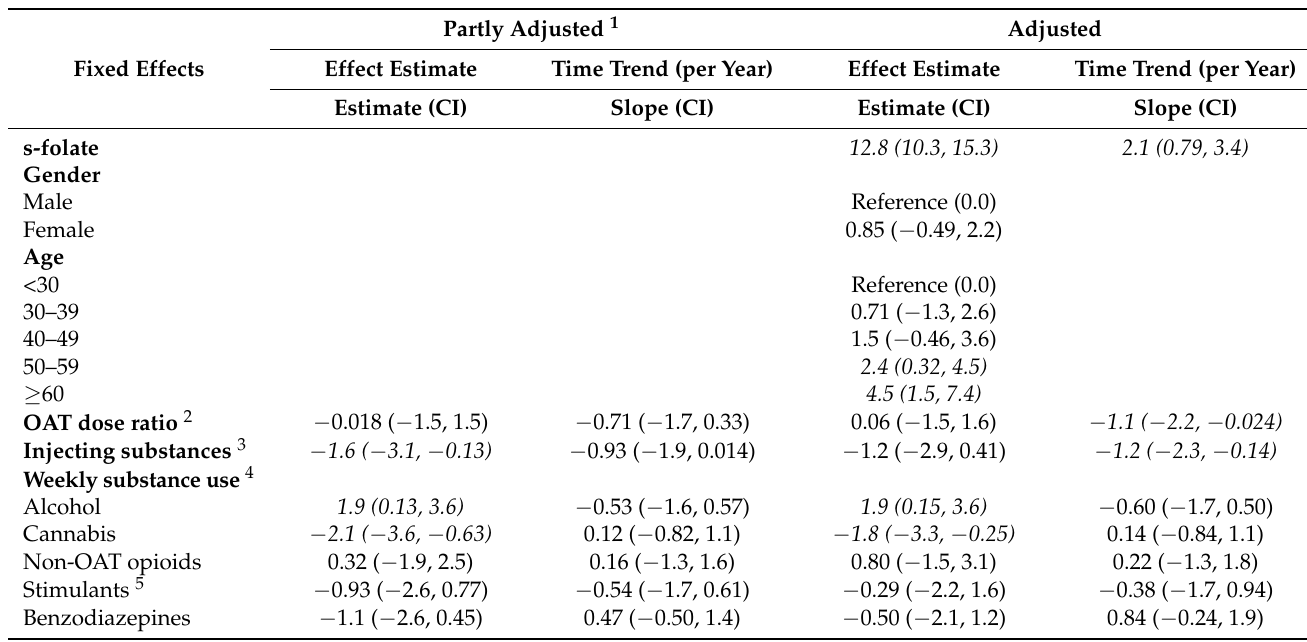
Table 2. Linear mixed model of serum folate concentration (nmol/L) adjusted for sociodemographic and clinical factors, including substance use